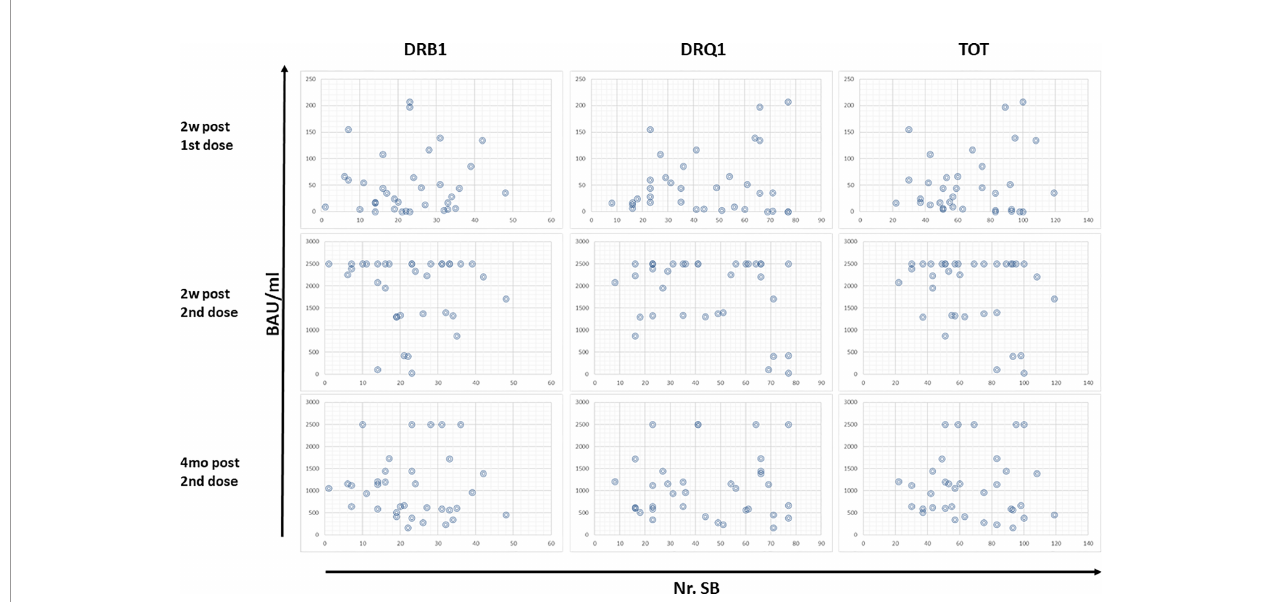
FIGURE 4 | Correlation between Ab titers and predicted SB. The Ab titers at the different timepoints have been correlated with the number of SB predicted for HLA- DR and DQ for each vaccinee. Each circle represents a subject.